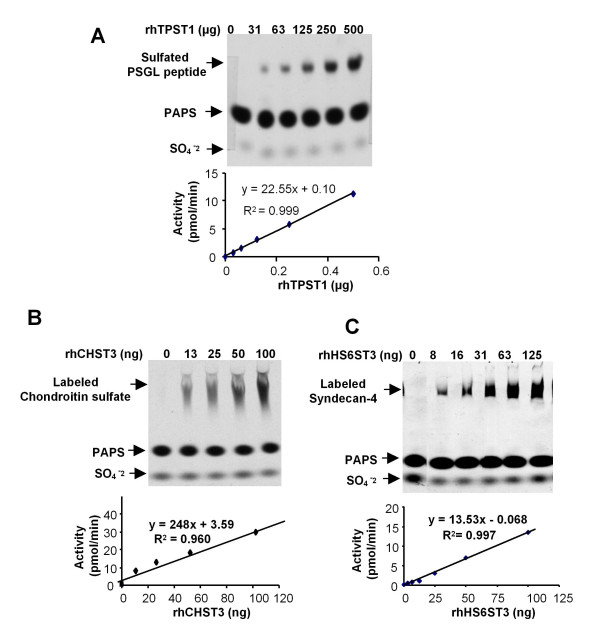
Examples showing the versatility of the sulfotransferase assay. A) rhTPST1 assay using PSGL-1 peptide as the acceptor. B) rhCHST3 assay using chondroitin sulfate as the acceptor. C) rhHS6ST3 assay using recombinant human syndecan-4 as the acceptor. See text for experimental conditions.